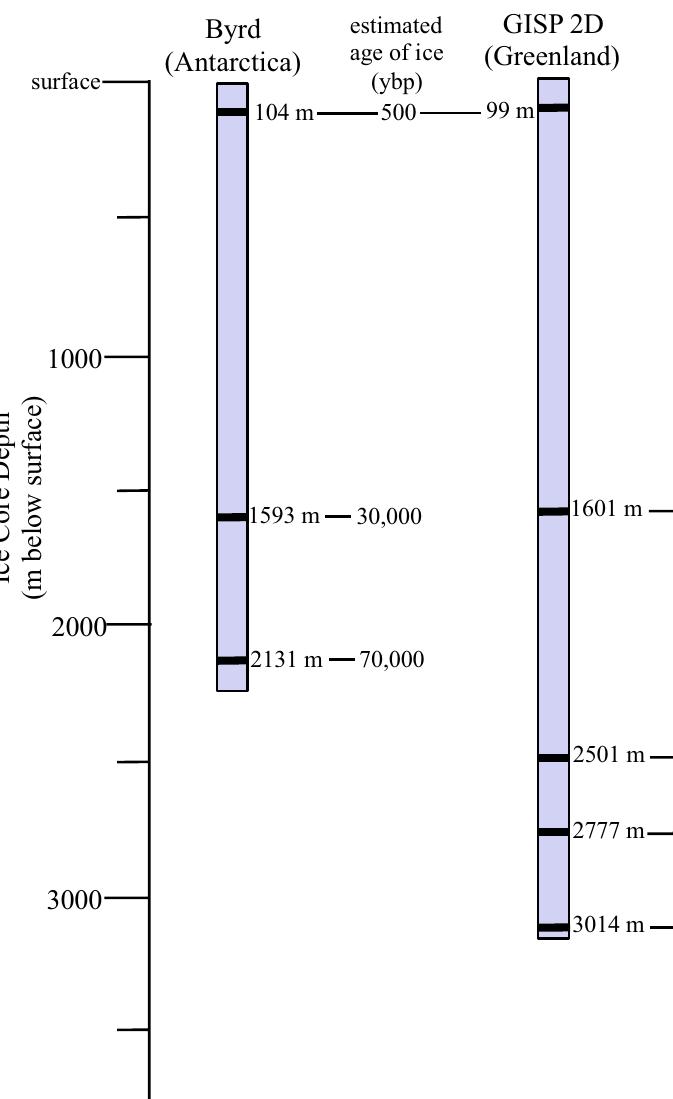
Figure 9. Depths and estimated ages of ice core sections used in this study. Atmospheric levels (all in ppmv): 500 ybp = 250; 10,500 and 105,000 ybp = 230; 70,000 ybp = CO 2